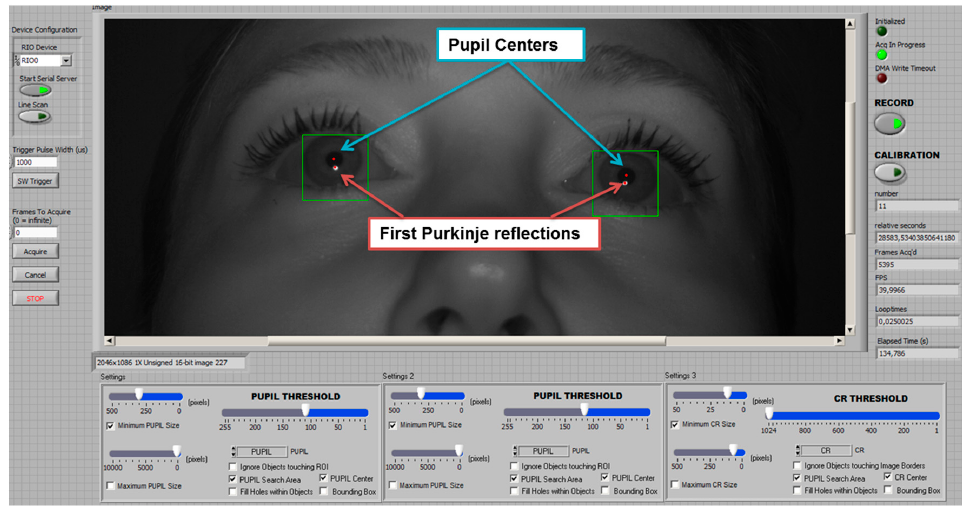
Figure 6. User interface menu of the LabVIEW-based eye tracker.